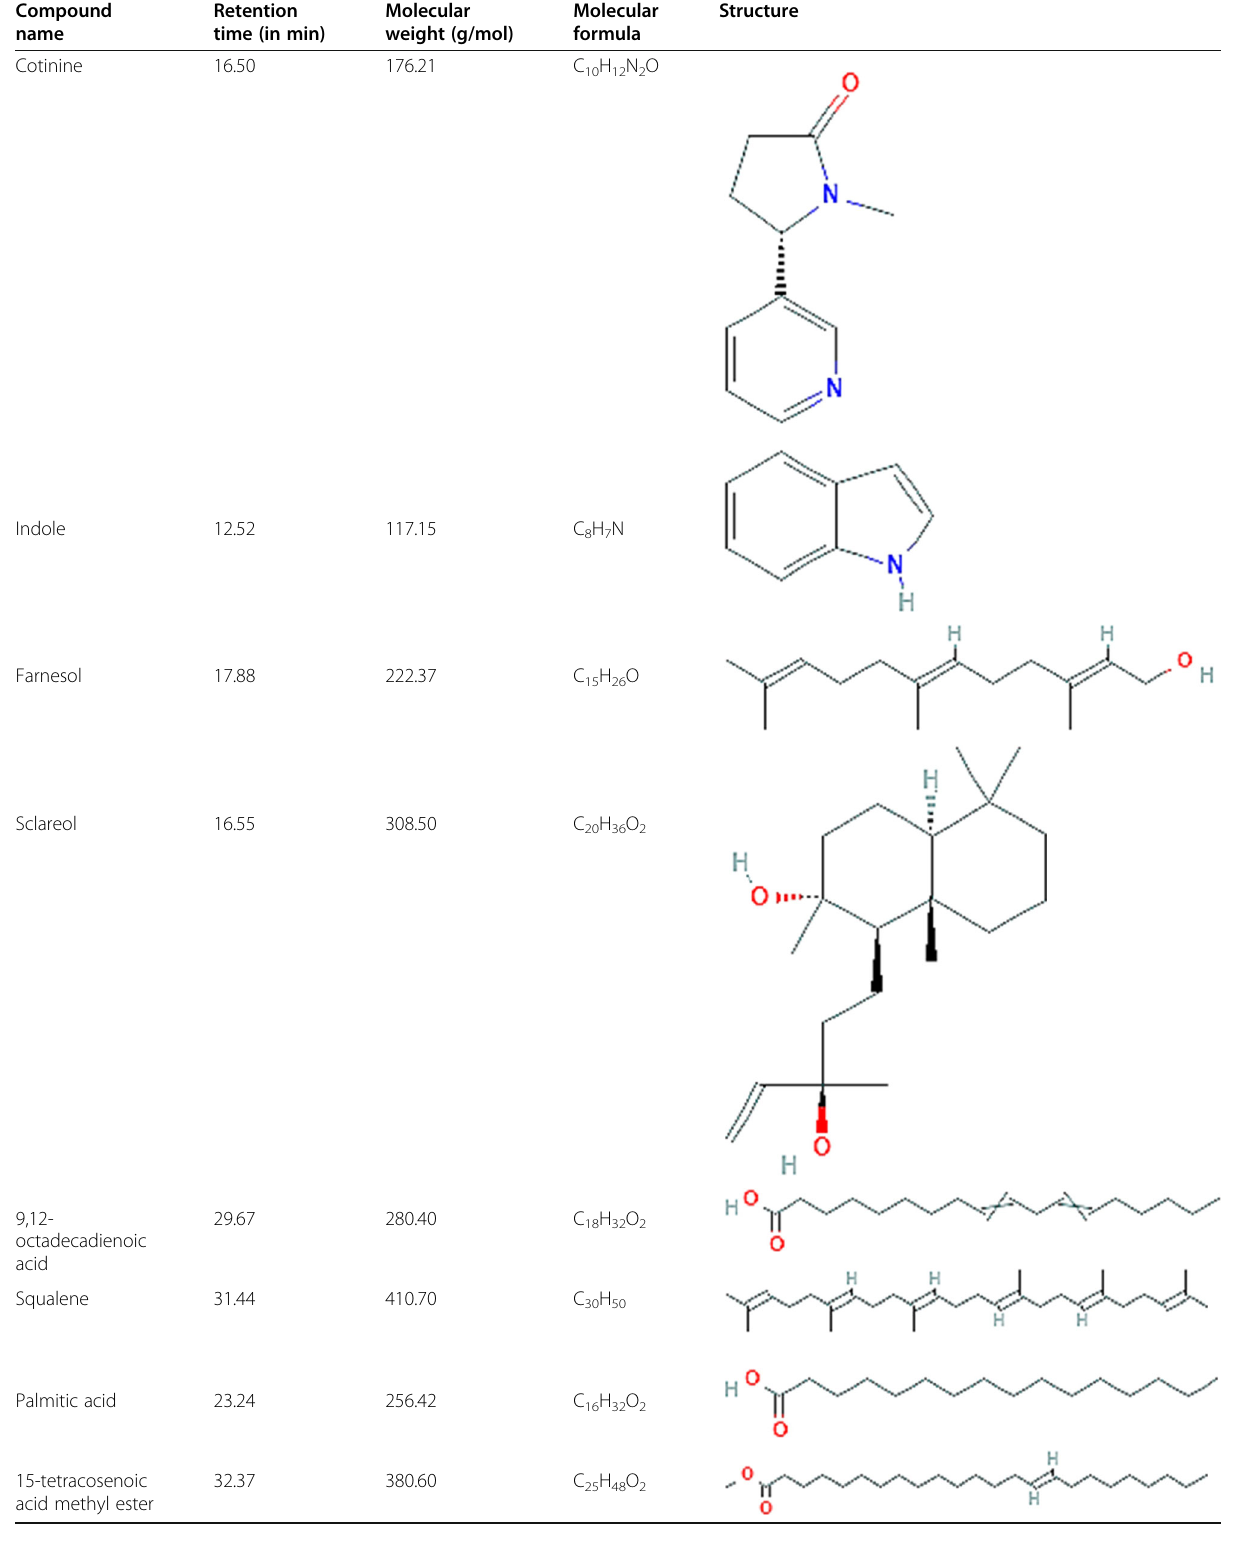
Table 2 Phytochemical compounds in the chloroform and acetone leaf extract of Nicotiana tabacum